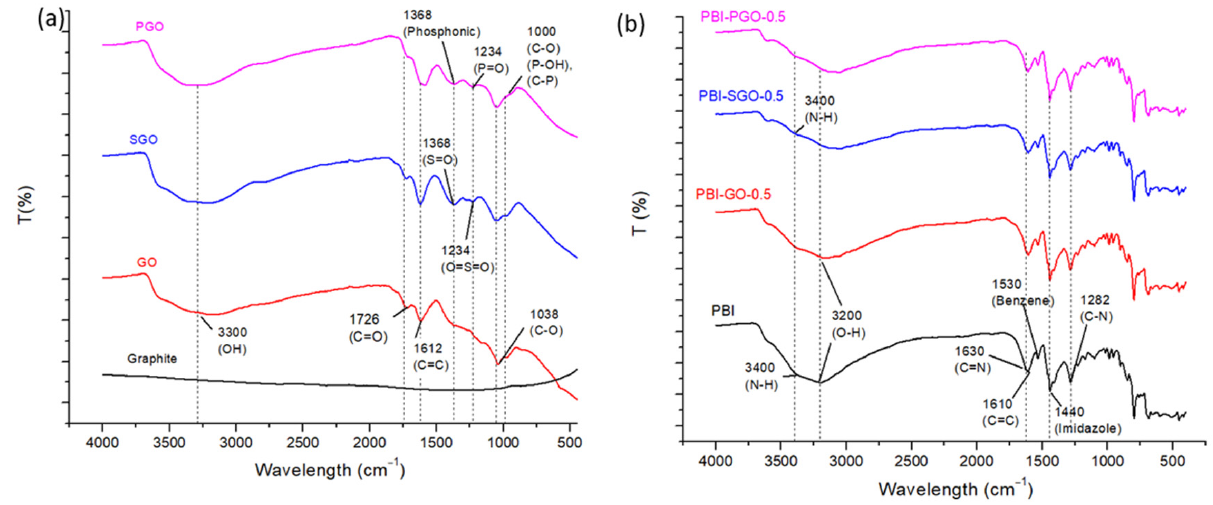
Figure 2. Fourier transform infrared (FTIR) spectra of ( a ) fillers and ( b ) membranes.